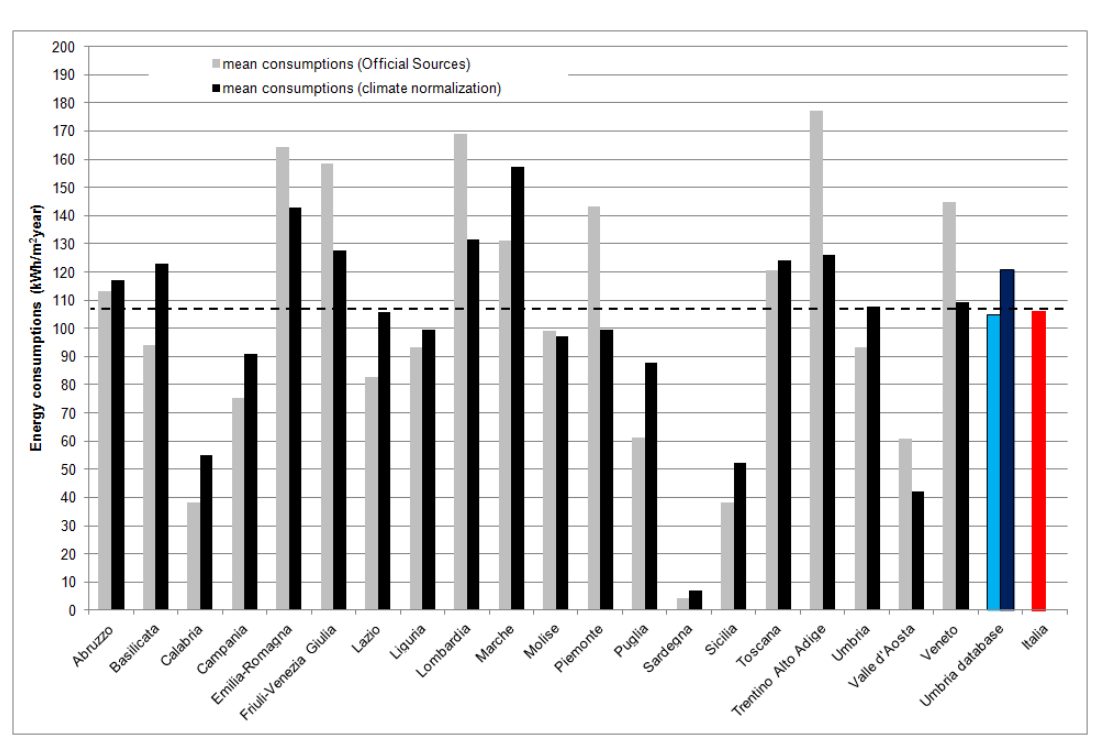
Figure 3. Comparison of the energy consumption of Umbrian buildings with the mean values of Italy and of the various Italian